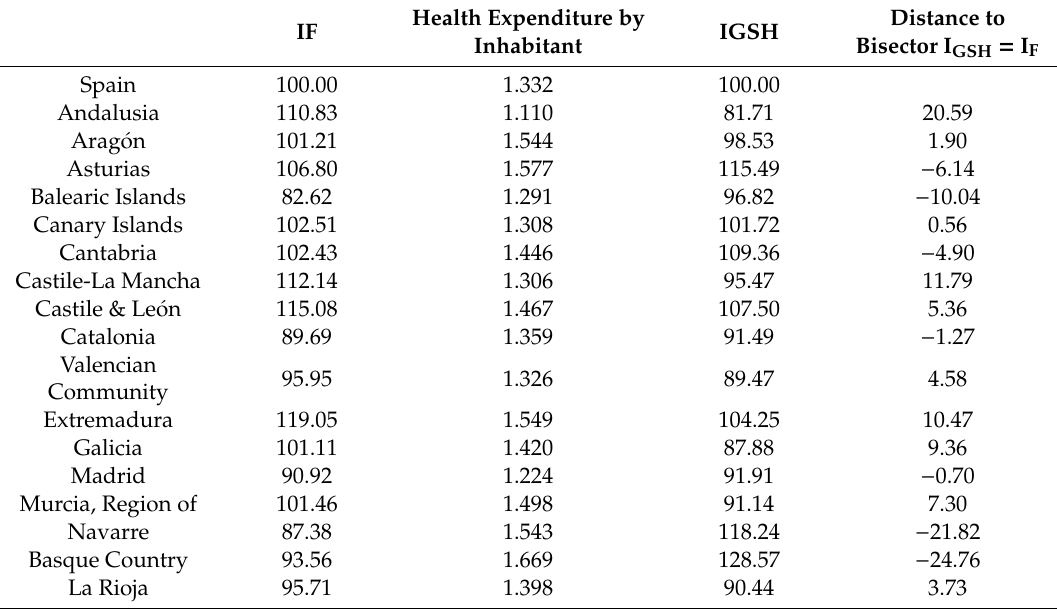
Table 7. Indices IF, Health Expenditure by Inhabitant, IGSH.